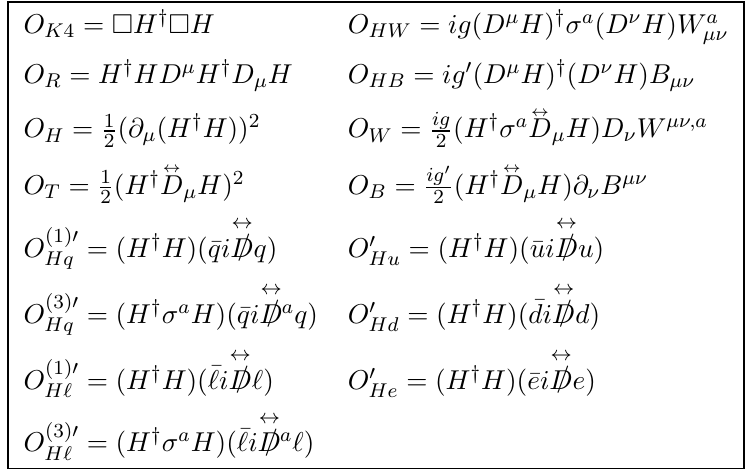
Table 2 . The additional dimension-6 SMEFT operators, produced by integrating out a real singlet scalar, that are in the Green’s basis, but not the Warsaw basis. For consistency we use the sign and normalization conditions of